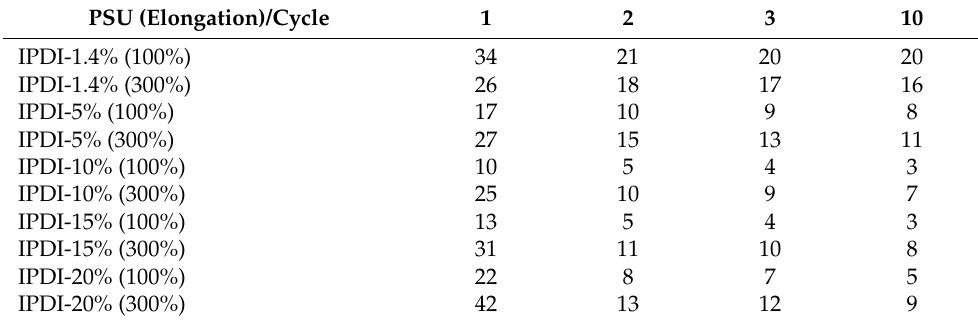
Figure 9. Results of tensile hysteresis measurements on PSU elastomers synthesized from IPDI with HS contents between 1.4% (copolymer) and 20%. ( a ) 100%-hysteresis curves (1st cycle) and corresponding mean hysteresis values ( b ) of the 1st and 10th cycles. ( c ) 300%-hysteresis curves (1st cycle) and corresponding mean hysteresis values of the elastomers ( d ) at the 1st and 10th cycles. The error bars represent the standard deviation of three repeated measurements. Hysteresis at 100% strain in the 1st cycle decreases from approximately 34% (1.4% HS content) to 10% (10% HS content) and increases again to approximately 22% at 20% HS content. Hysteresis in the 10th cycle decreases from 20% (1.4% HS content) to 3% (10% HS content) and slightly increases again to 5% at an HS content of 20%. At 300% strain, the lowest 1st-cycle-hysteresis value is measured in the PSU elastomer containing 10% HS. The highest hysteresis is over 41%, as observed for the elastomer with an HS content of 20%. Table 4. Influence of HS content on tensile hysteresis for PSU elastomers synthesized from IPDI with HS contents ranging from 1.4% (copolymer) to 20%. The values are given for the first three cycles and the last (10th) cycle at 100% and 300% strain. The given values are the mean values from three repeated measurements and are rounded to